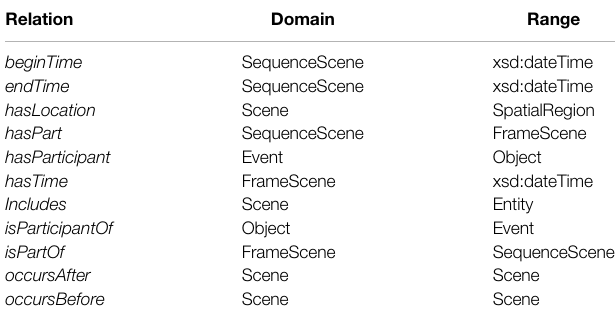
TABLE 2 | Relations associated with a Scene, including their domain and